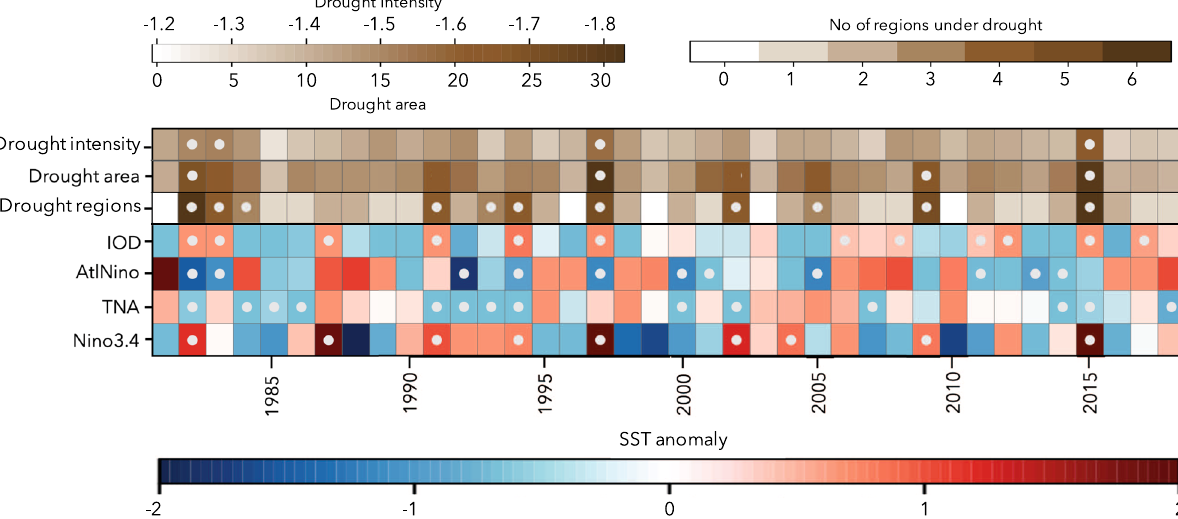
Fig. 2 Drought characteristics and variability modes. Top three rows show the drought characteristics from CHIRPS and bottom four rows show the four SST indices from National Oceanic and Atmospheric Administration (NOAA) Optimum Interpolation (OI) SST dataset version 2 (V2) in each year (1981 – 2018). The white dots indicate years with severe droughts (row 1), widespread droughts (row 2) and compound droughts (row 3). White dots in the bottom four rows indicate years with positive SST anomalies ( ≥ 0.5 σ ) over Niño3.4 and IOD regions and negative ( ≤ − 0.5 σ ) SST anomalies over TNA and AtlNiño